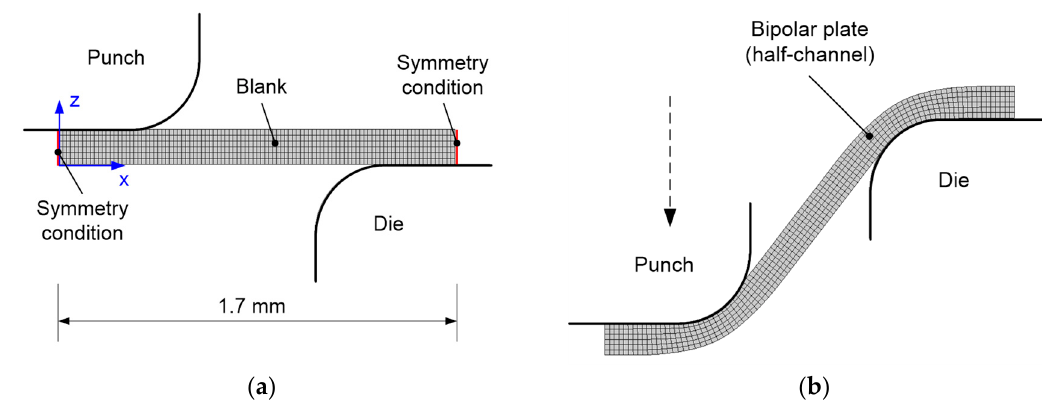
Figure 9. Finite element model of the stamping process (half-channel) assuming plane strain conditions: ( a ) initial configuration; ( b ) final configuration.